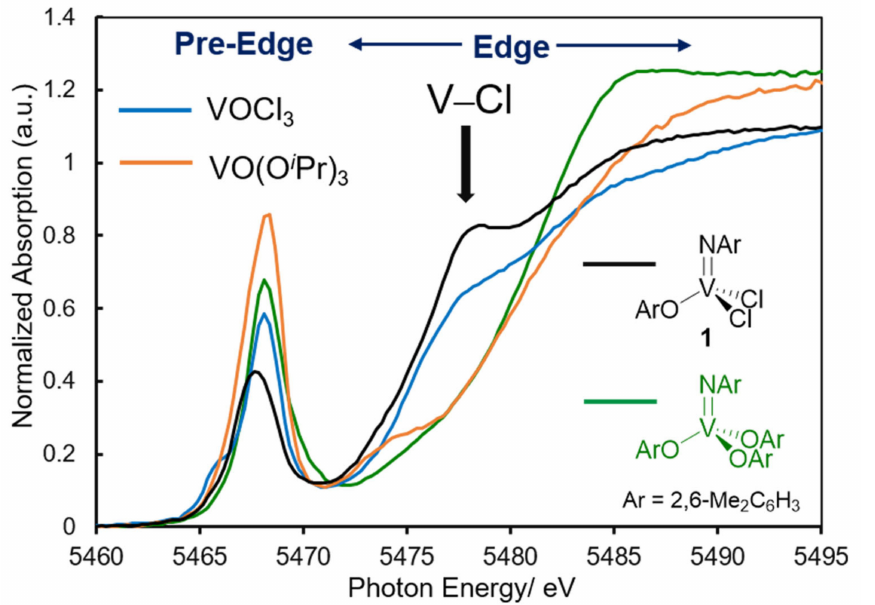
Figure 2. V K-edge XANES spectra for VOCl 3 , VO(O i Pr) 3 , V(NAr)Cl 2 (OAr) ( 1 , Ar = 2,6-Me 2 C 6 H 3 ), and V(NAr)(OAr) 3 (in toluene at 25 ◦ C; 5.46 keV, 50 µ